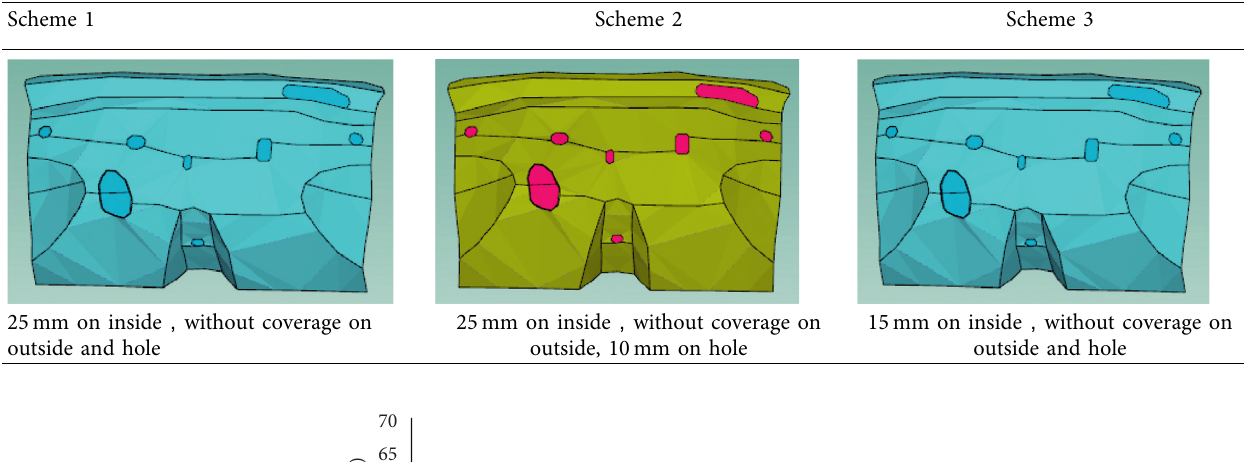
Table 5: Coverage thickness of three schemes.